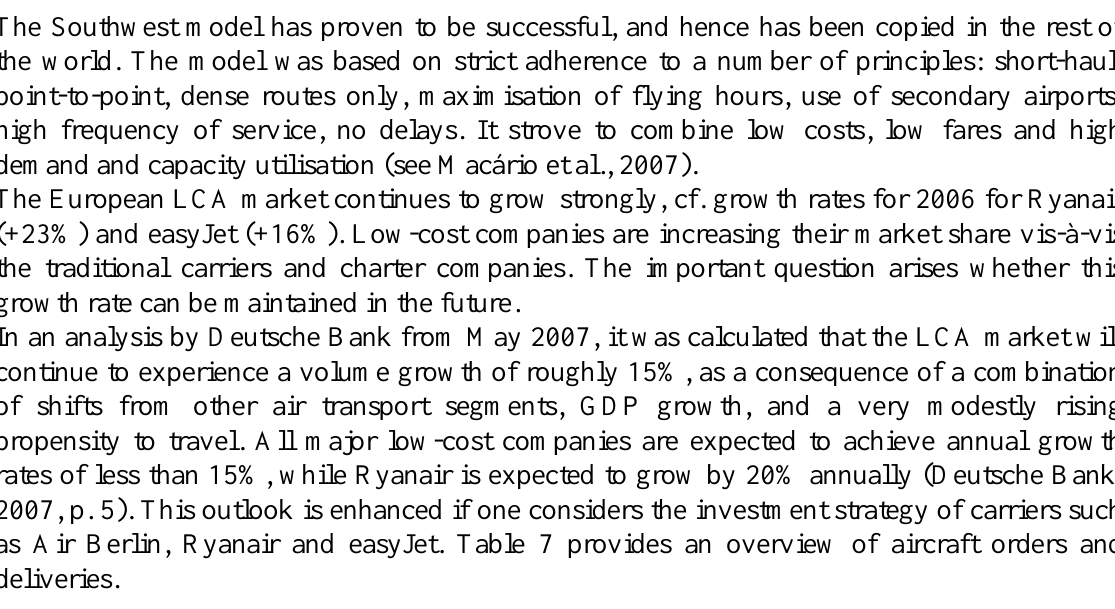
Table 7. Estimated number of aircraft and passengers carried by European LCAs until